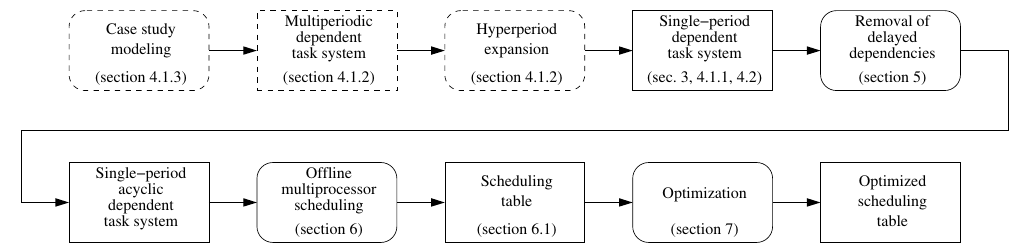
Figure 1 The proposed implementation